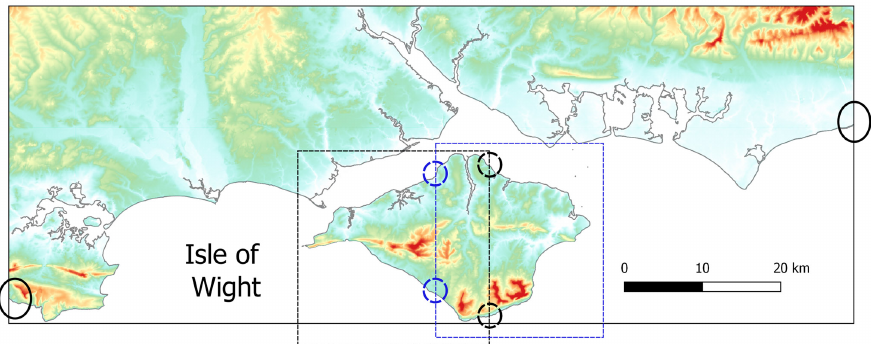
Figure 5. The algorithm used to delineate the coastline searches the edges of the tiles to find the start point of the coastline. The solid grey line represent the coastline over the coloured DEM (i.e. the warmer the colour the higher the elevation). The coastline cuts the edges of the DEM at the locations indicated by the solid black circles. The coastline of the Isle of Wight does not cut the edges of the DEM and therefore the user needs to define two smaller DEM domains (represented as dashed black and blue rectangles for the west and east side of the isle). The isle coastline now cuts the smaller domains at the locations indicated by the blue and black dashed circles. It is recommended to allow some overlap between the smaller domains to ensure that the cliff metrics are well resolved near the edges.